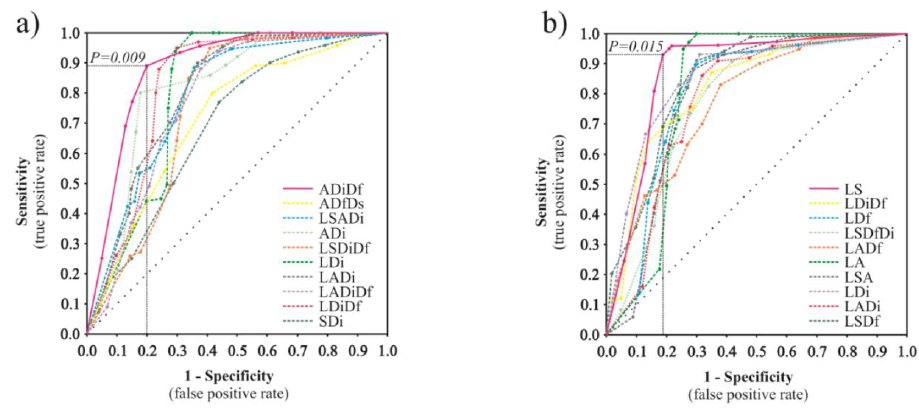
Figure 5. Receiver operating characteristic (ROC) curves for the 10 best models of the Roglio ( a ) and Milia ( b ) basins. Acronyms of Factors Combination: L: Lithology; S: Slope angle; A: Slope aspect; Di: Distance to hydrographic elements; Df: Distance to tectonic lineaments; Ds: Distance to degradation scarps.